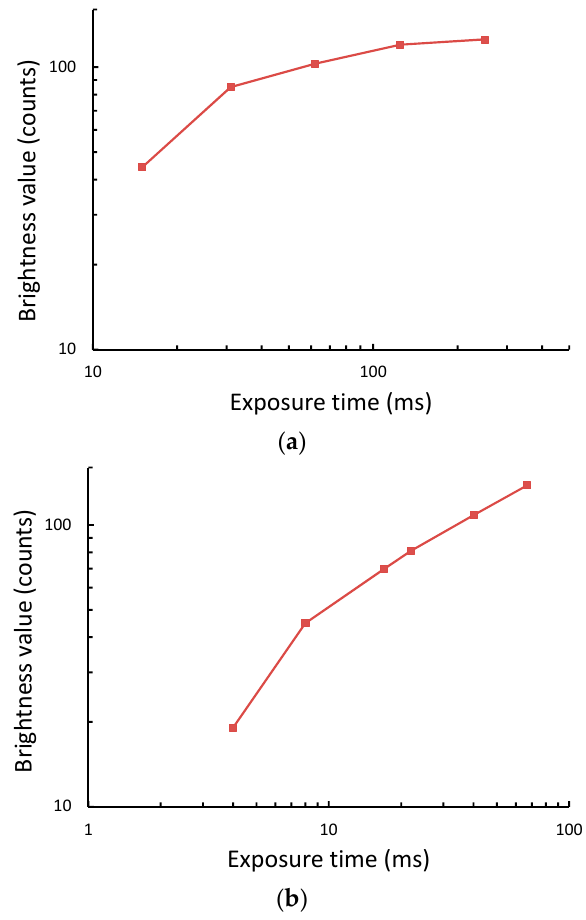
Figure 4. Brightness values obtained from a white background of the test strip as a function of camera exposure time ( a ) using the web camera reader and ( b ) using the iPhone reader.